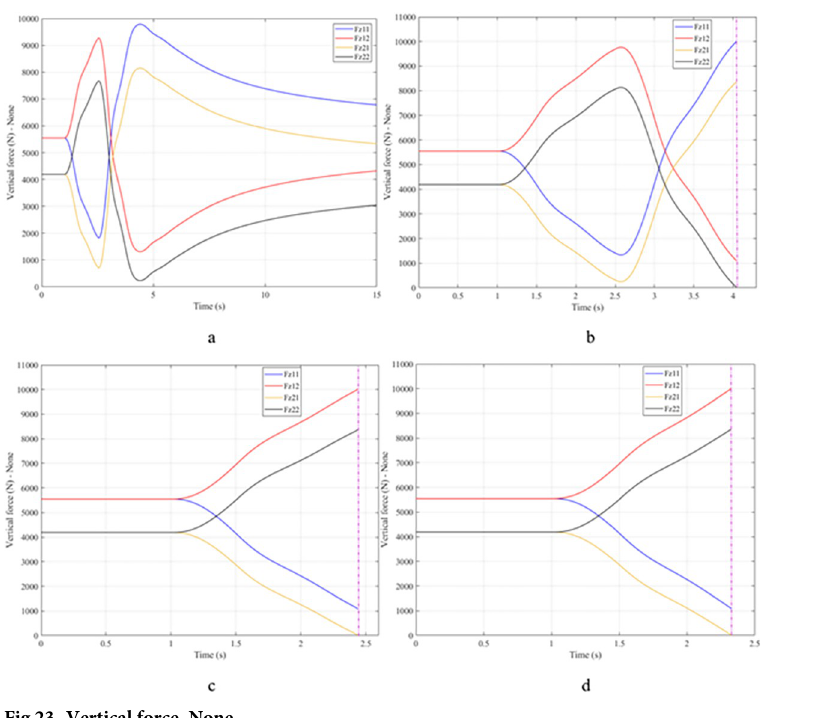
Fig 23. Vertical